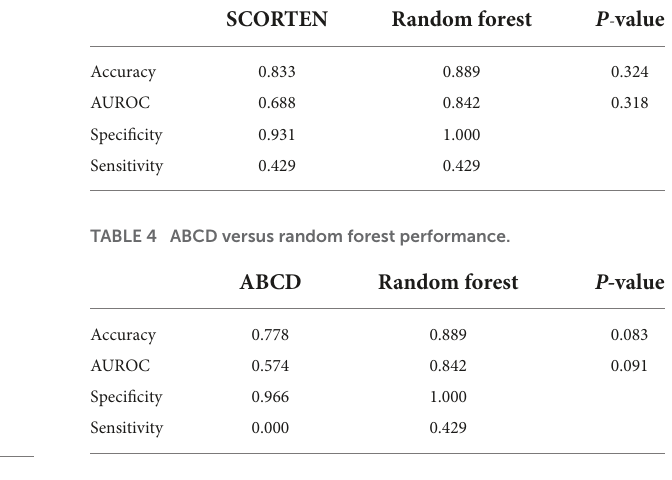
TABLE 3 SCORTEN versus random forest performance.